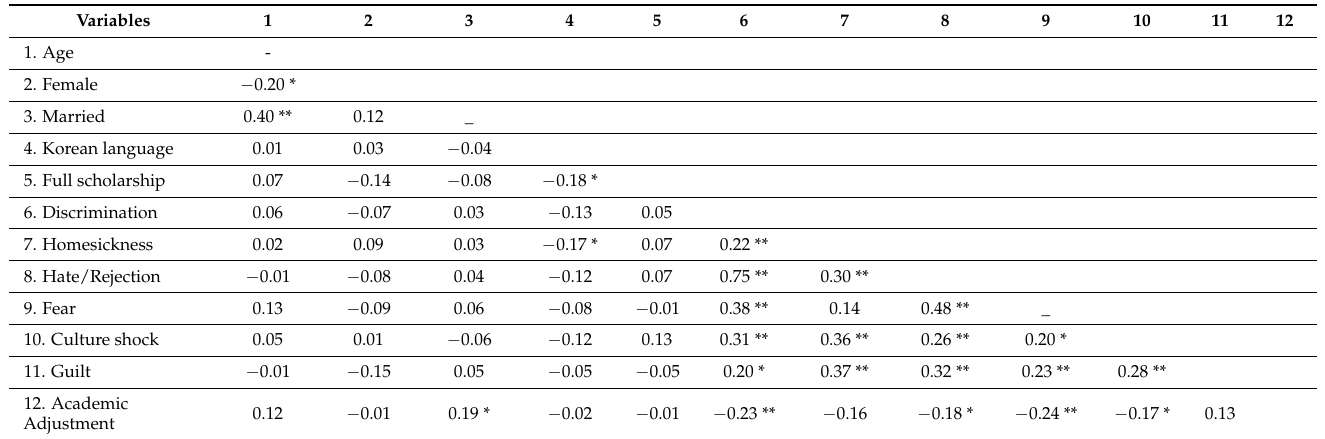
Table 2. Correlation of statistical control, independent, and dependent